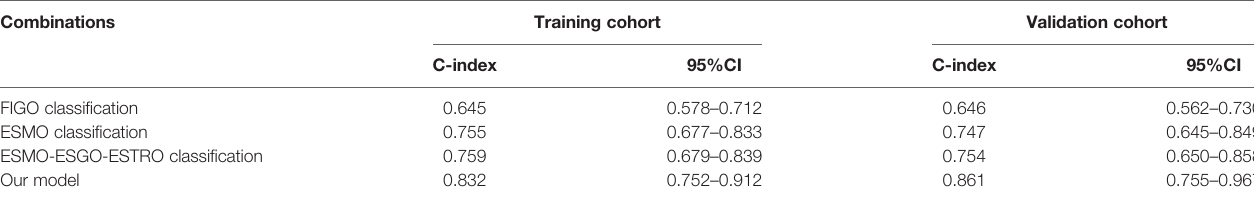
TABLE 4 | The discriminatory power (C-index) of different risk strati fi cation systems in the training cohort and validation cohort. Combinations